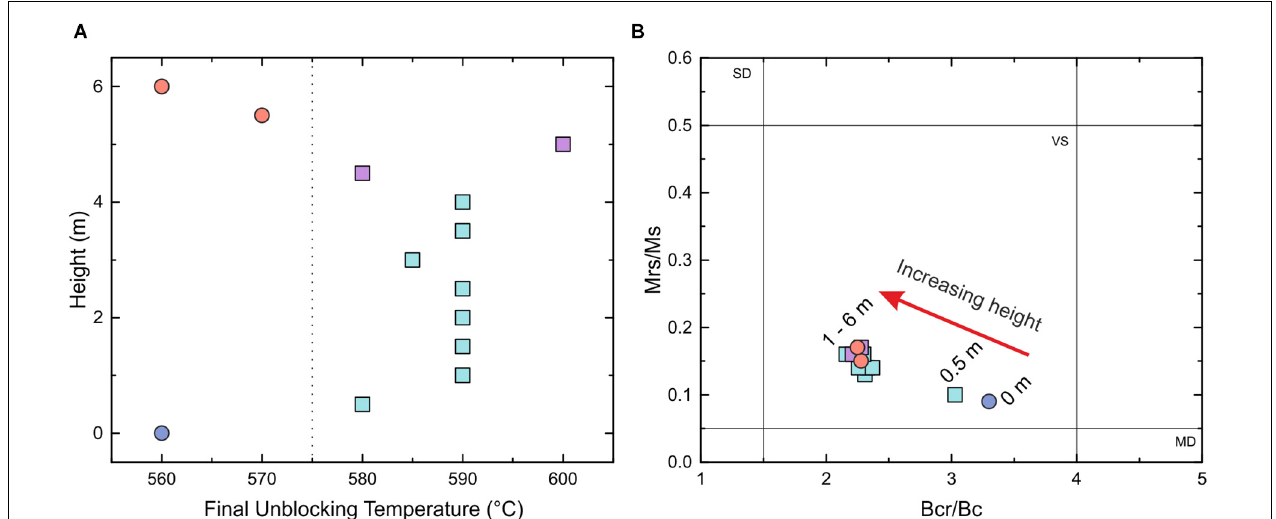
FIGURE 4 | Graphs showing results from experiments to identify the magnetic carriers and their domain states at each 0.5 m height across the crinanite sill thickness. (A) Unblocking temperatures against height, obtained from three component demagnetization experiments (modified Lowrie method), where the vertical dashed line separates the AMS groupings, and (B) Day plot showing single-domain (SD), vortex-state (VS) and multi-domain (MD) states, where Bcr/Bc is coercivity of remanence relative to bulk coercivity and Mrs/Ms is the remanent magnetic saturation relative to magnetic saturation. In both plots, circles indicate AMS group A and squares indicate AMS group B, and the colors indicate the 4 AARM groupings.